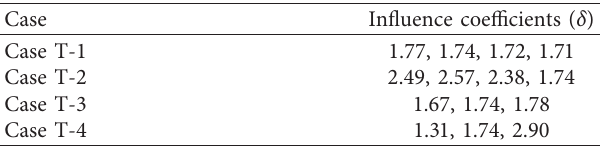
Figure 21: Maximum strain of T-shaped connection under different parameters: (a) Case T-1, II-site; (b) Case T-2, 30 ° branch angle; (c) Case T-3, 0.2191 m pipe diameter; (d) Case T-4, 30 ° incident angle. Table 11: Influence coefficients of T-shaped connection in different cases.